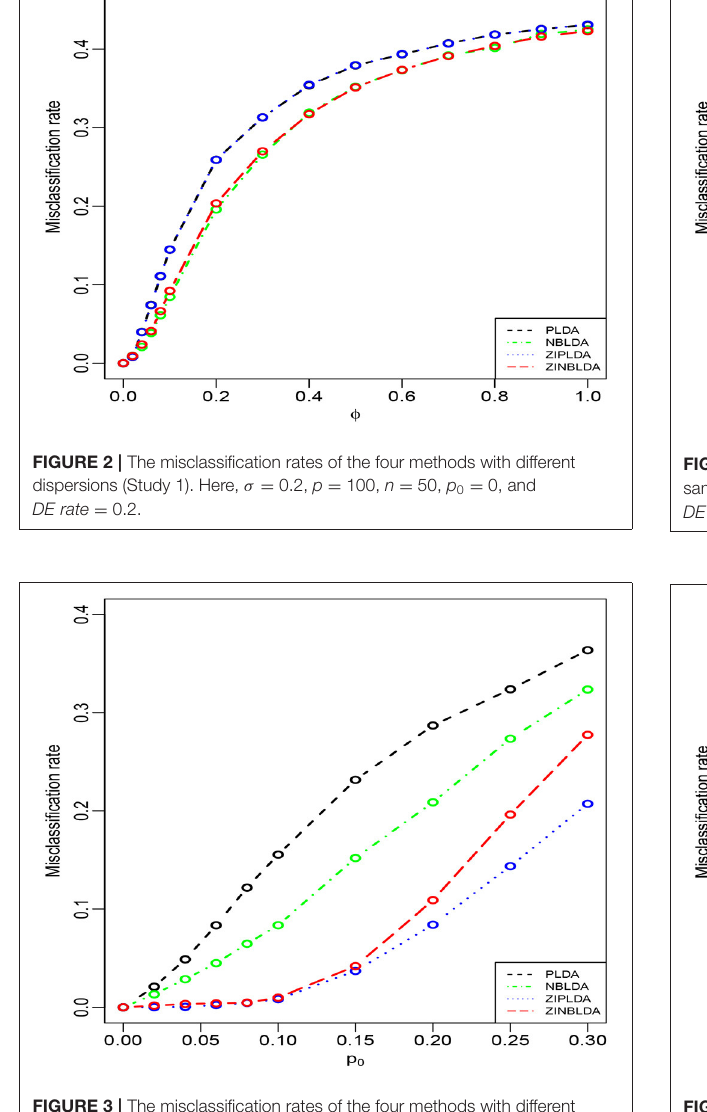
FIGURE 5 | The misclassification rates of the four methods with different numbers of genes (Study 4). Here, σ = 0.2, n = 50, φ = 0, p 0 = 0.1, and DE rate =